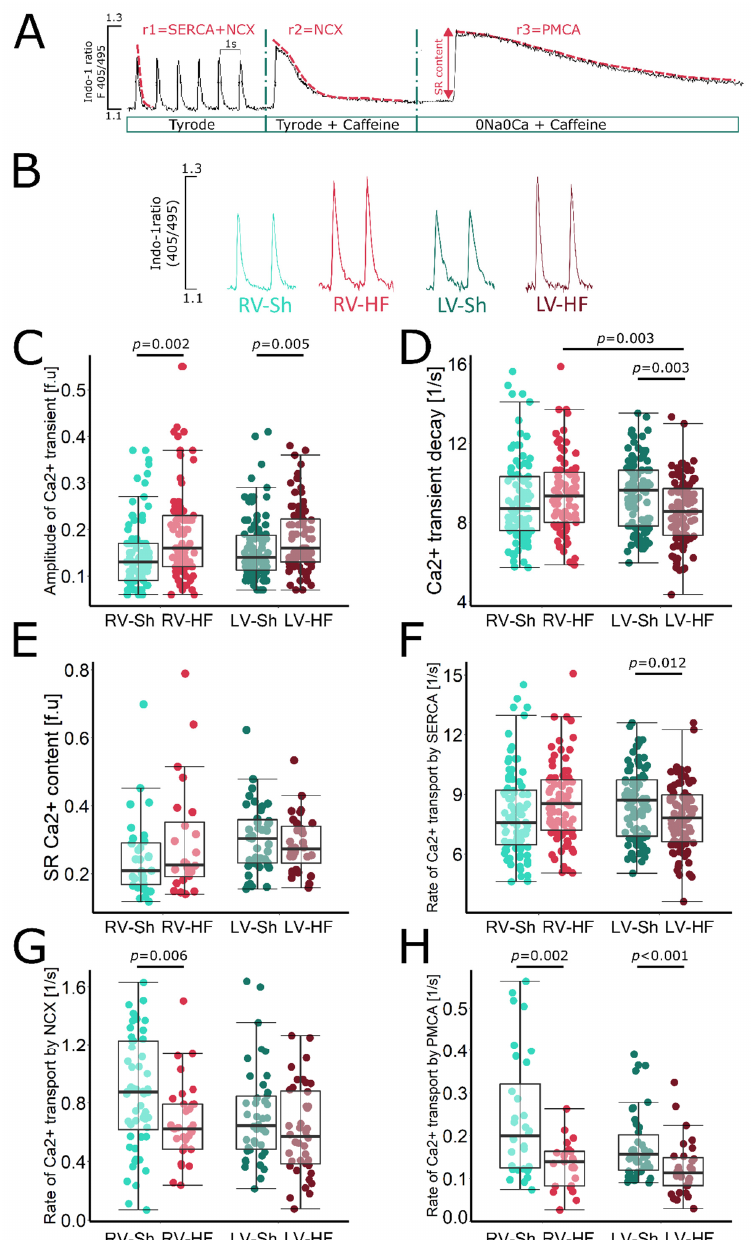
Figure 3. Calcium signalling in cardiomyocytes isolated from LV and RV of sham-operated (Sh) and heart-failure (HF) rats. ( A ) Experimental protocol used to assess Ca 2+ signalling in cardiomyocytes: cardiomyocytes were superfused with Tyrode solution and were stimulated at 1 Hz, caffeine was applied to cardiomyocytes superfused with Tyrode or Na + /Ca 2+ free solution (0Na0Ca). Exponential curves were fitted to decaying part of electrically or caffeine-evoked Ca 2+ transients and rate constants of their decay (r1, r2 and r3) were calculated. The rate of Ca2+ transport by SERCA2a, NCX1 and PMCA was calculated according to formulas: rSERCA = r1–r2, rNCX = r2–r3 and rPMCA = r3. ( B ) Representative original recording of electrically evoked Ca 2+ transients from cardiomyocytes isolated from left and right ventricles of healthy and failing hearts. ( C ) Amplitude of Ca 2+ transient, ( D ) rate of Ca 2+ transient decay (r1) in electrically stimulated myocytes, ( E ) sarcoplasmic reticulum